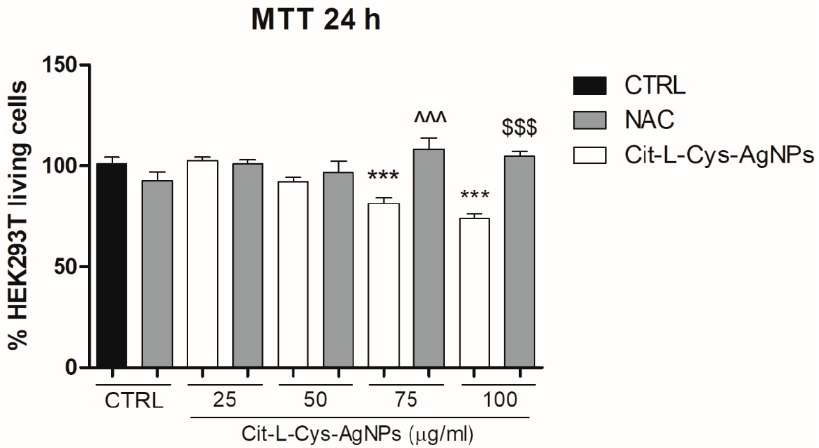
Figure 10. Effect of AgNPs/L-cys/citr on cells viability in presence of NAC. MTT assay on HEK293T pretreated with NAC (2 mM) and treated with cit-L-cys-AgNPs (25-50-75-100 µ g/mL) for 24 h. *** p < 0.001 vs. CTRL; ˆˆˆ p < 0.001 vs. Cit-L-cys-AgNPs 75 µ g/mL; $$$ p < 0.001 vs. Cit-L-cys-AgNPs 100 µ g/mL.